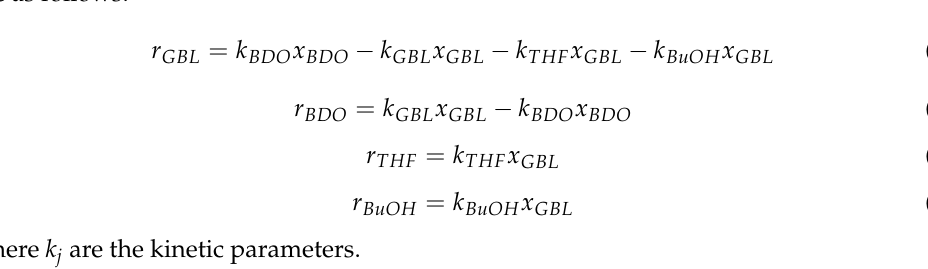
Table 1. Reaction mechanism for the construction of the first power law model: Model 1. Reactions Kinetic Parameters Hypothesis GBL + 2 H 2 (cid:11) BDO k GBL , k BDO Main reaction